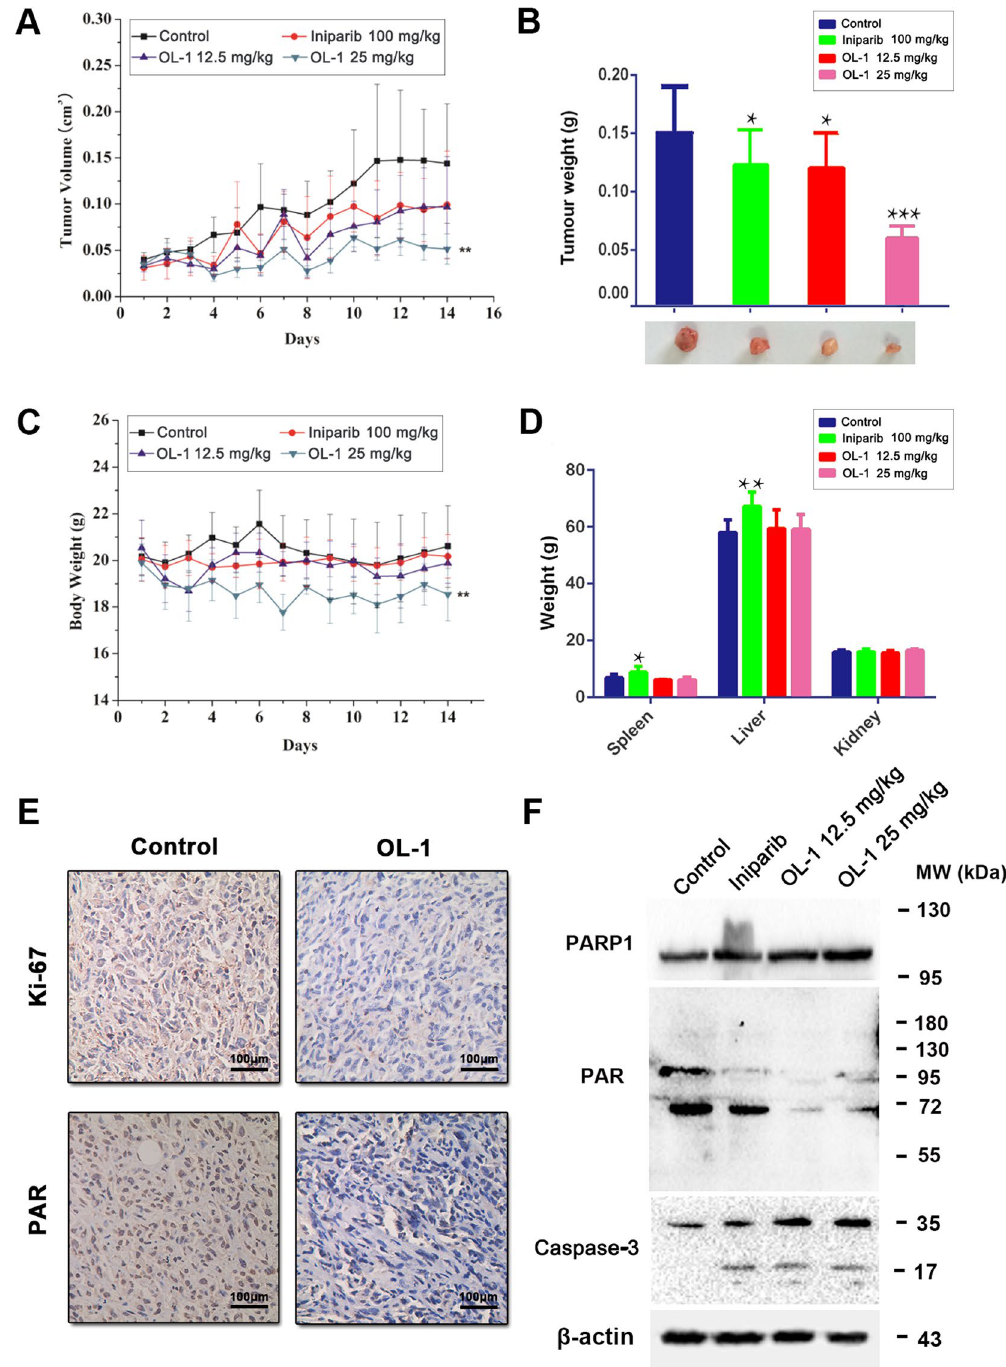
Figure 12. OL-1 displays potent anti-tumor activity in vivo . ( A ) Relative tumor volumes of mice (n = 6) injected i.p. with PBS, Iniparib (100 mg/kg/d), low dose (12.5 mg/kg/d) and high dose (25 mg/kg/d) of OL-1. ** P < 0.01; compared with control group. ( B ) Tumor weights of mice injected i.p. PBS, Iniparib (100 mg/ kg/d), low dose (12.5 mg/kg/d) and high dose (25 mg/kg/d) of OL-1. * P < 0.05; *** P < 0.001 compared with control group. ( C ) Body weights of mice during treatment. ** P < 0.01; compared with control group. ( D ) The weights of liver, spleen and kidney of mice in different groups were measured. * P < 0.05; ** P < 0.01; compared with control group. ( E ) Immunohistochemistry analysis of Ki-67 and PAR expression. Scale bar = 200 μ m. ( F ) Western blot analysis of PARP, PAR and Caspase-3. Tumor tissues excised from the MDA-MB-436 xenograft mice were lysed. Each lane was loaded with 30 μ g cell lysates, β -actin was used as a loading